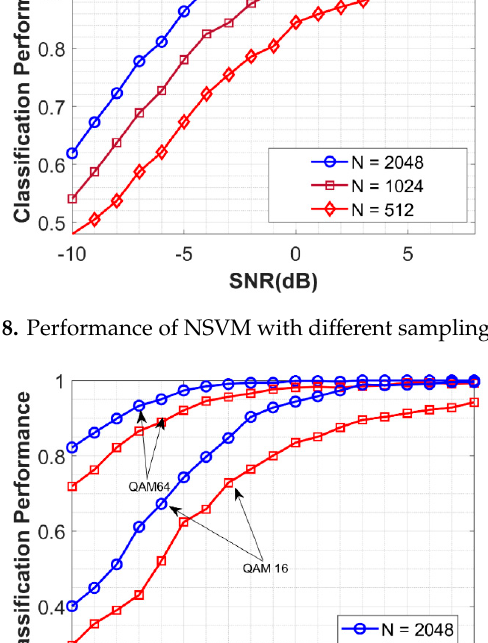
Table 3. Confusion Matrix of NSVM at SNR = 0 dB.